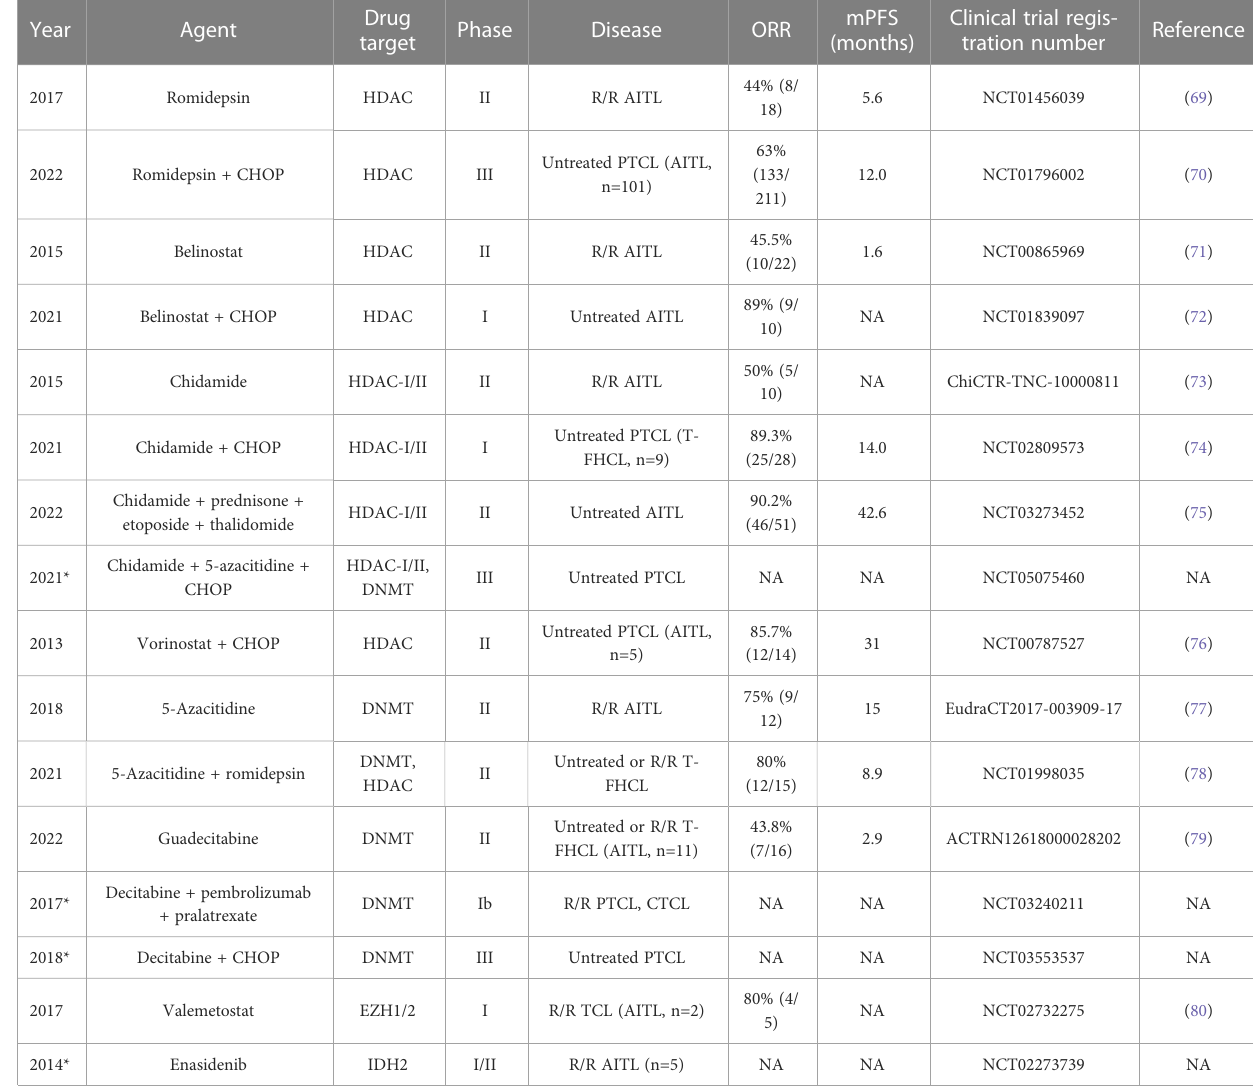
TABLE 4 Novel and experimental agents targeting epigenetic enzymes in